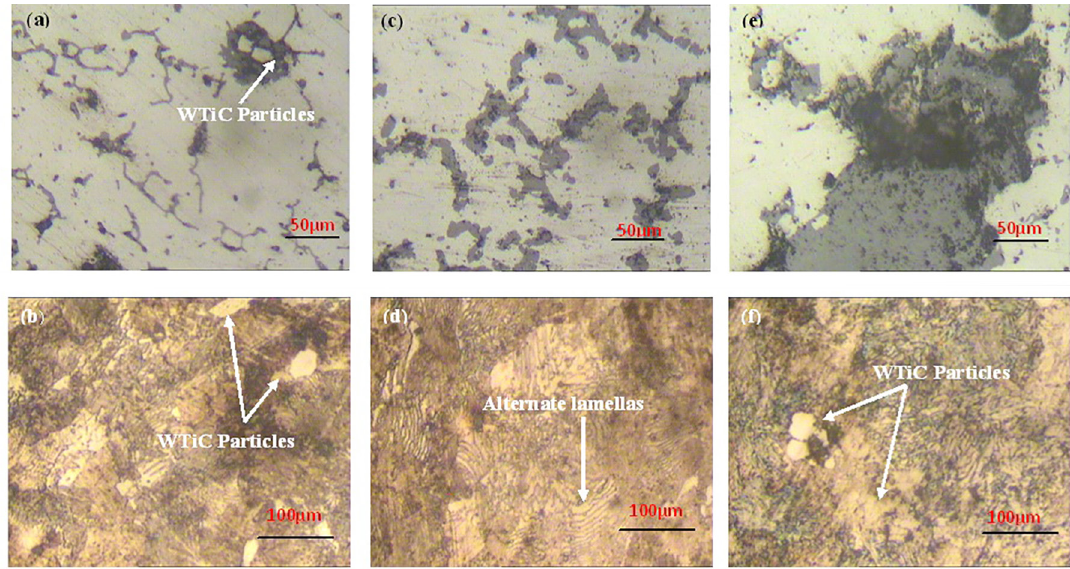
Figure 2. Optical micrographs of the as-sintered and hot extruded P/M alloy steels. (a) & (b) Fe-1%C-1%W-1%Ti; (c) & (d) Fe-1%C- 2%W-1%Ti; (e) & (f) Fe-1%C-4%W-1%Ti